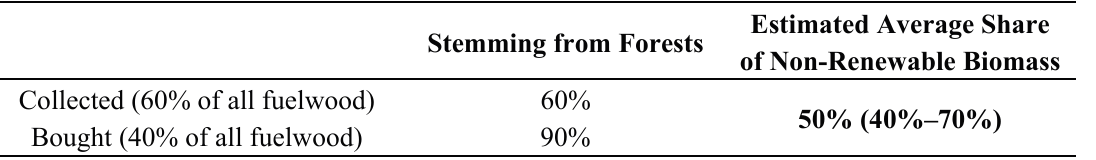
Table 7. Estimated share of non-renewable biomass.